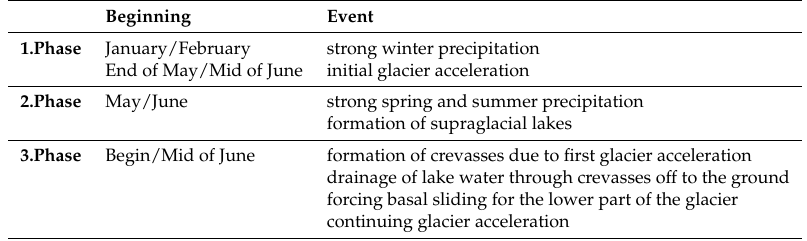
Table 6. Chronological process of surface velocities, supraglacial lakes, and